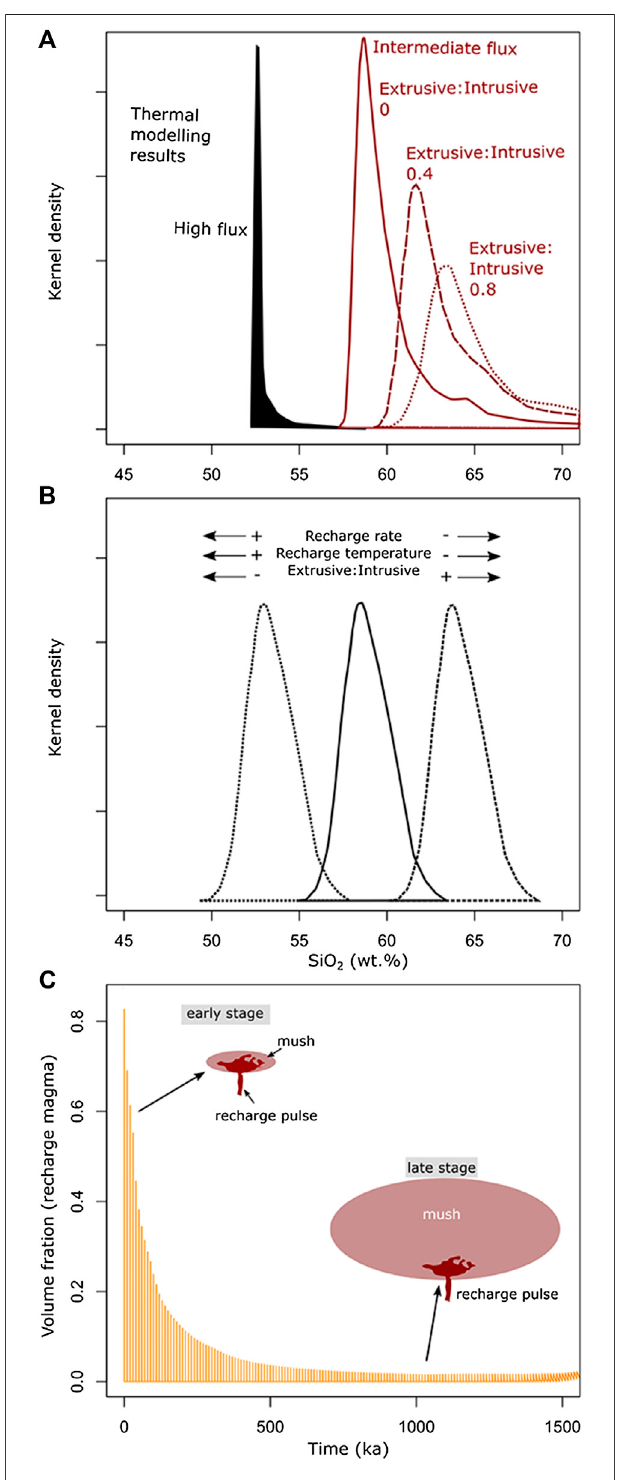
FIGURE14| Controlsonpetrologic modesofcompositionally restricted volcanoes. (A) Modeled distributions of SiO 2 content (wt%) of eruptible magma( < 50%crystallinityandallinterstitialmelt)areshownfor150 km 3 sized intrusions built with different magma fl uxes (black: 0.1061 m/yr and red curves: 0.0019 m/yr) and for different extrusive:intrusive ratios of 0 (solid), 0.4